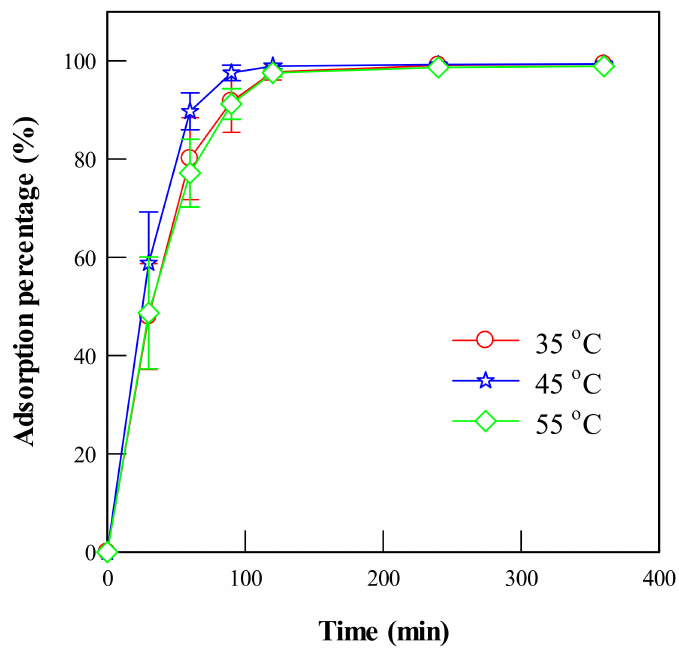
Figure 6. Effect of adsorption time on ectoine adsorption percentage at different temperatures (Dowex ® HCR-S = 1 g, initial ectoine = 1000 mg/L, aqueous solution = 10